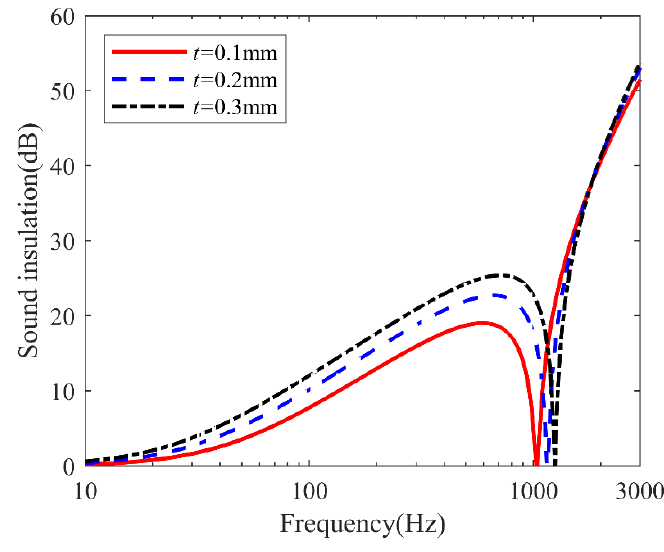
Figure 9. Effect of honeycomb wall thickness on sound insulation.